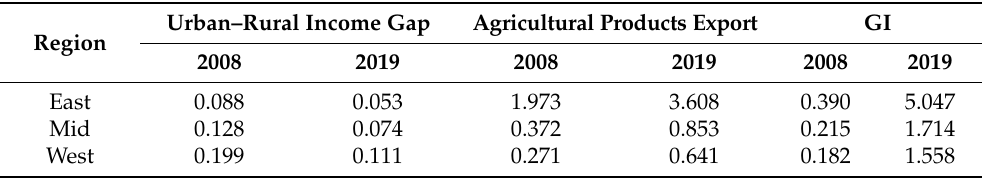
Table 3. The development degree of GI, agricultural product export, and urban–rural income gap in 2008 and